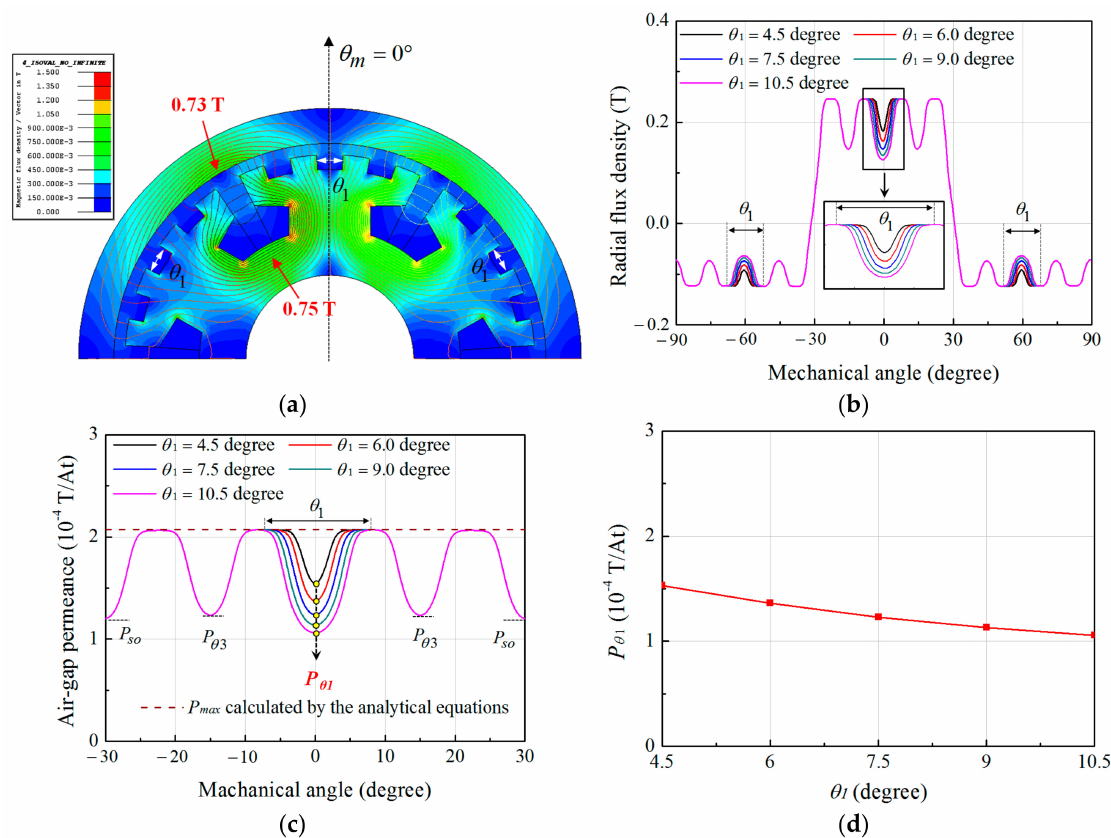
Figure 4. Radial flux density distributions in the air-gap due to the armature windings and the corresponding permeance distributions according to θ 1 . ( a ) Flux density distribution when θ 1 = 7.5 degree; ( b ) Radial flux density distributions; ( c ) Air-gap permeance distributions; ( d ) Variations of P θ 1 .